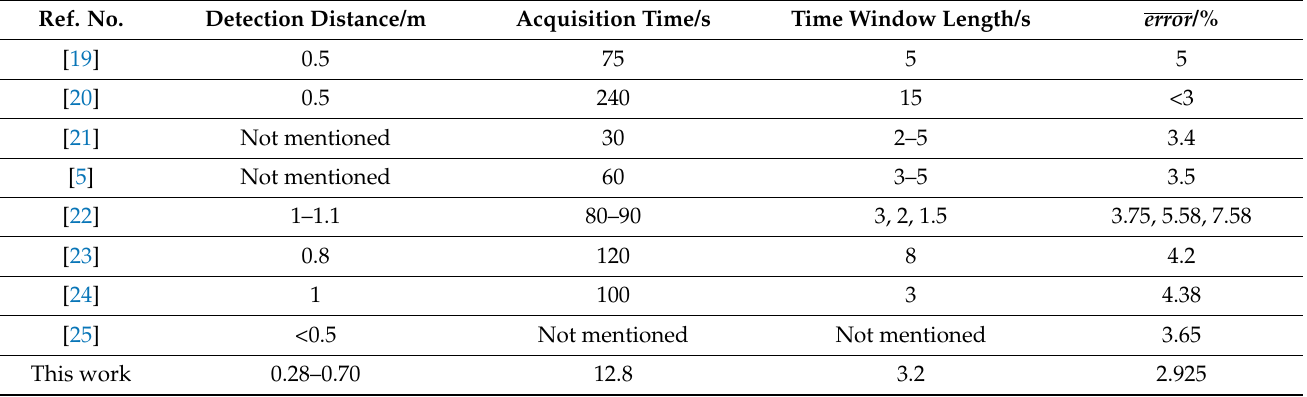
Table 2 lists the comparison results with other works. We set the distance between 0.28–0.70 m to simulate an office scene realistically. When detecting the real-time heart rate, the time window length was generally required to be less than 5 s. In order to better verify the performance of the proposed method in detecting the real-time heart rate, we set a 3.2 s time window for detecting the heart rate. In general, the shorter the time window, the lower the accuracy of the heart rate detection. As can be seen from the table, the biggest advantage of the proposed method is that the required detection time is short, and accurate heart rate detection can be performed at any time. Comparison of the proposed method with the other existing real-time heart rate detection